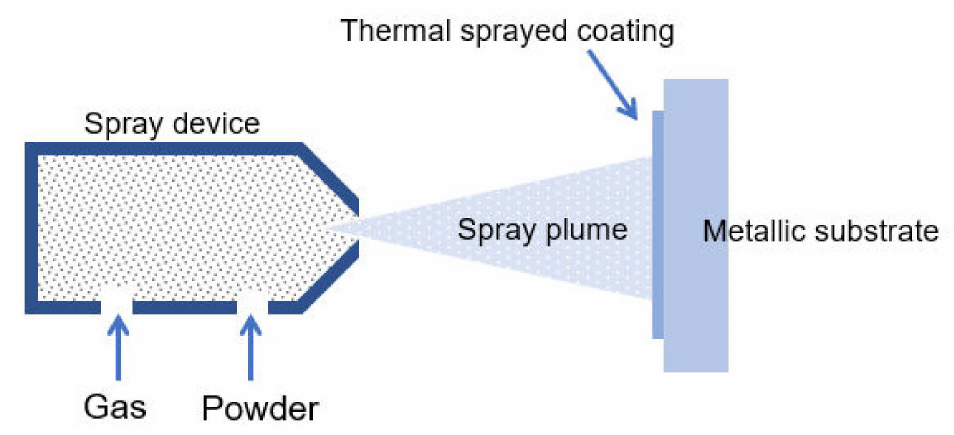
Figure 13. Schematic of thermal sprayed aluminium (TSA) coating process, which involves projecting small molten particles onto a prepared surface and achieving a continuous coating with strong surface